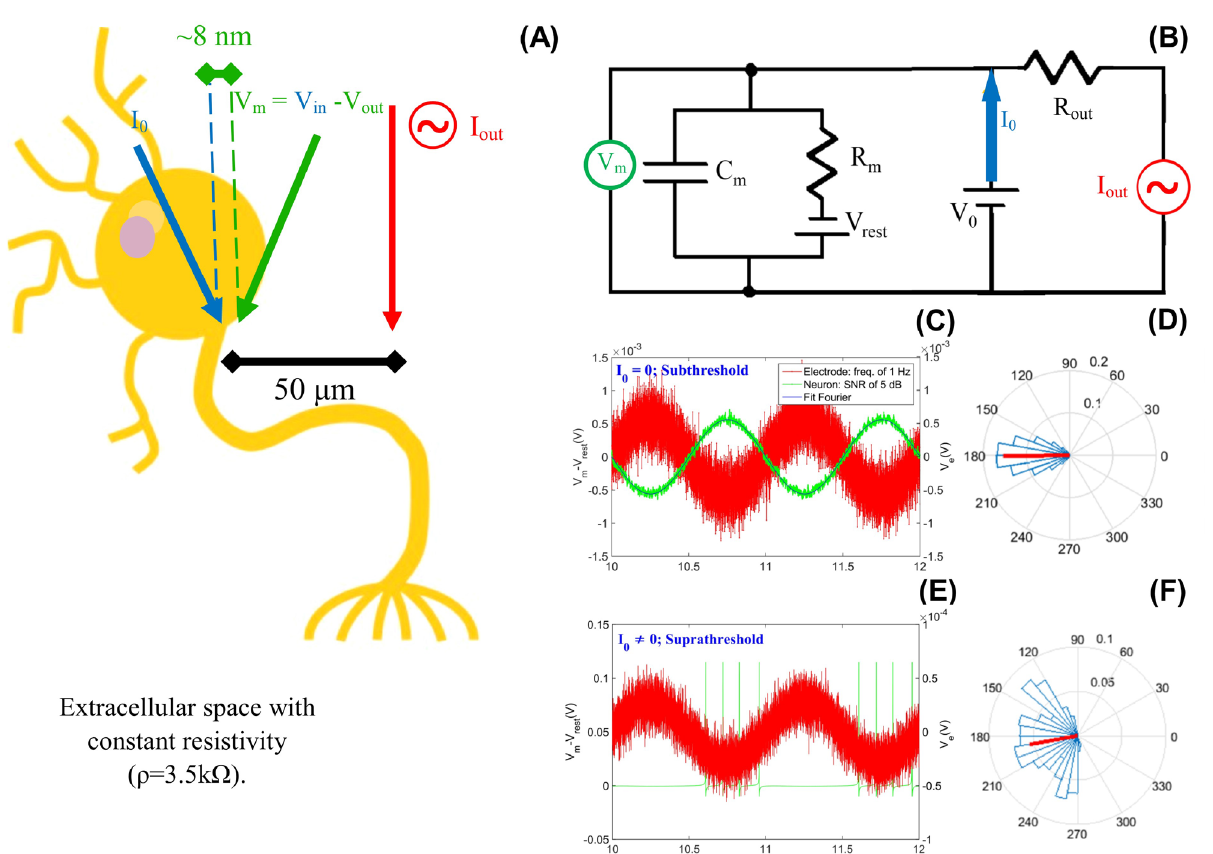
Figure 1. Schematic drawing of the cell membrane and its representative RC circuit for the Integrate-and-Fire quadratic model with ephaptic entrainment (QIF-E). Simulation of ephaptic neuronal entrainment via hybrid neuronal model. ( A ) Schematic drawing of the experience equivalent to the simulation. Two electrodes on the neuronal membrane provide the membrane potential (blue and green). The external electrode produce an oscillatory electric field via input stimulus ( I out in red). The intracellular electrode (blue) can inject a constant current ( I 0 ), differentiating the two simulation regimes: Subthreshold ( I 0 = 0 ) and Suprathreshold ( I 0 = 0 ). ( B ) RC circuit representing the QIF-E ephaptic model [see Eq. (3)]. ( C ) In subthreshold regime the input stimulus was represented in red and the frequency is 1 Hz and SNR of 5 dB, and the model response is in green. In blue, we see the signal filtered by the Fourier method, with the most intense frequency in the response signal. ( D ) Circular statistics of the phase differences between the input stimulus and the model response, calculated using the Hilbert transform method. The medium vector (red) and the classes of the circular histogram—dispersion— in blue. ( E ) In suprathreshold regime, the input stimulus is in red, the frequency used is 1 Hz and SNR of 5 dB. The model’s response indicates that spikes occur only at a certain stage of the stimulus signal. ( F ) Vector population data from ( E